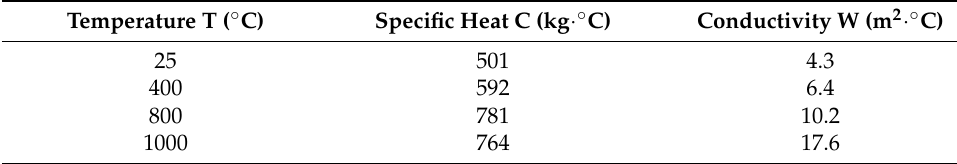
Table 2. Thermophysical parameters of NiCoCrAlY cladding material.